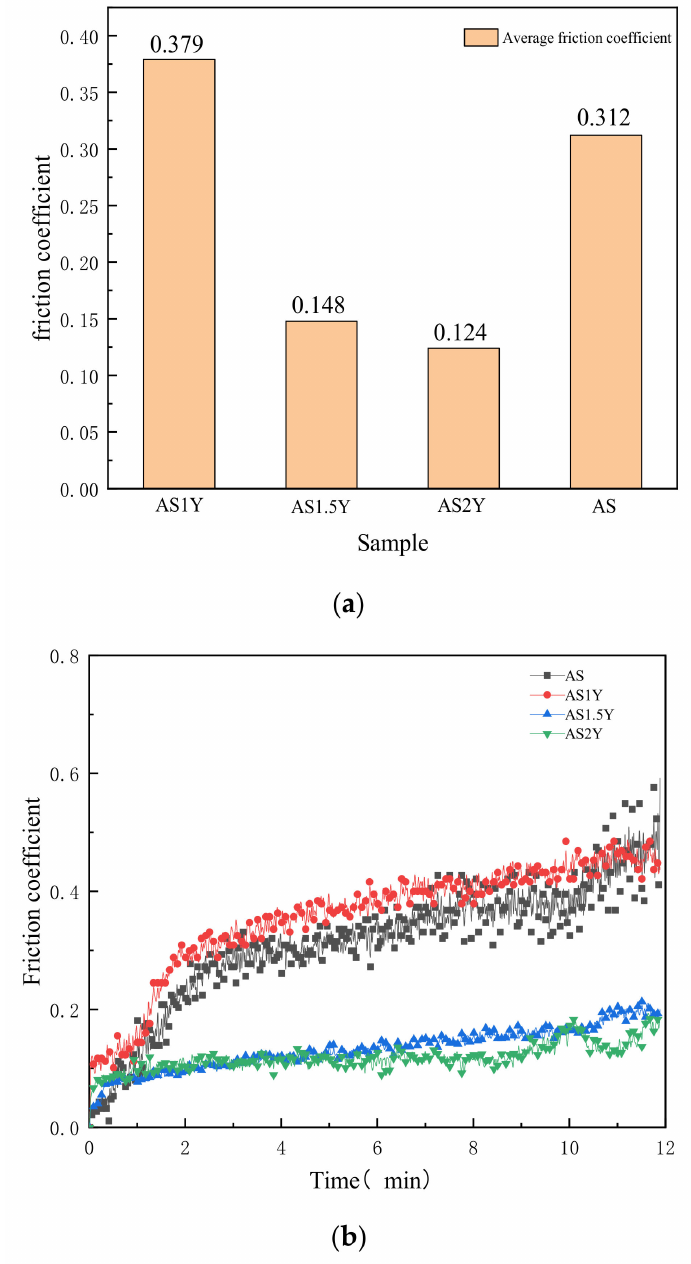
Figure 6. Comparison of the friction coefficient between the unmodified and Y 2 O 3 -modified coatings: ( a ) average friction coefficient, and ( b ) friction coefficient evolution